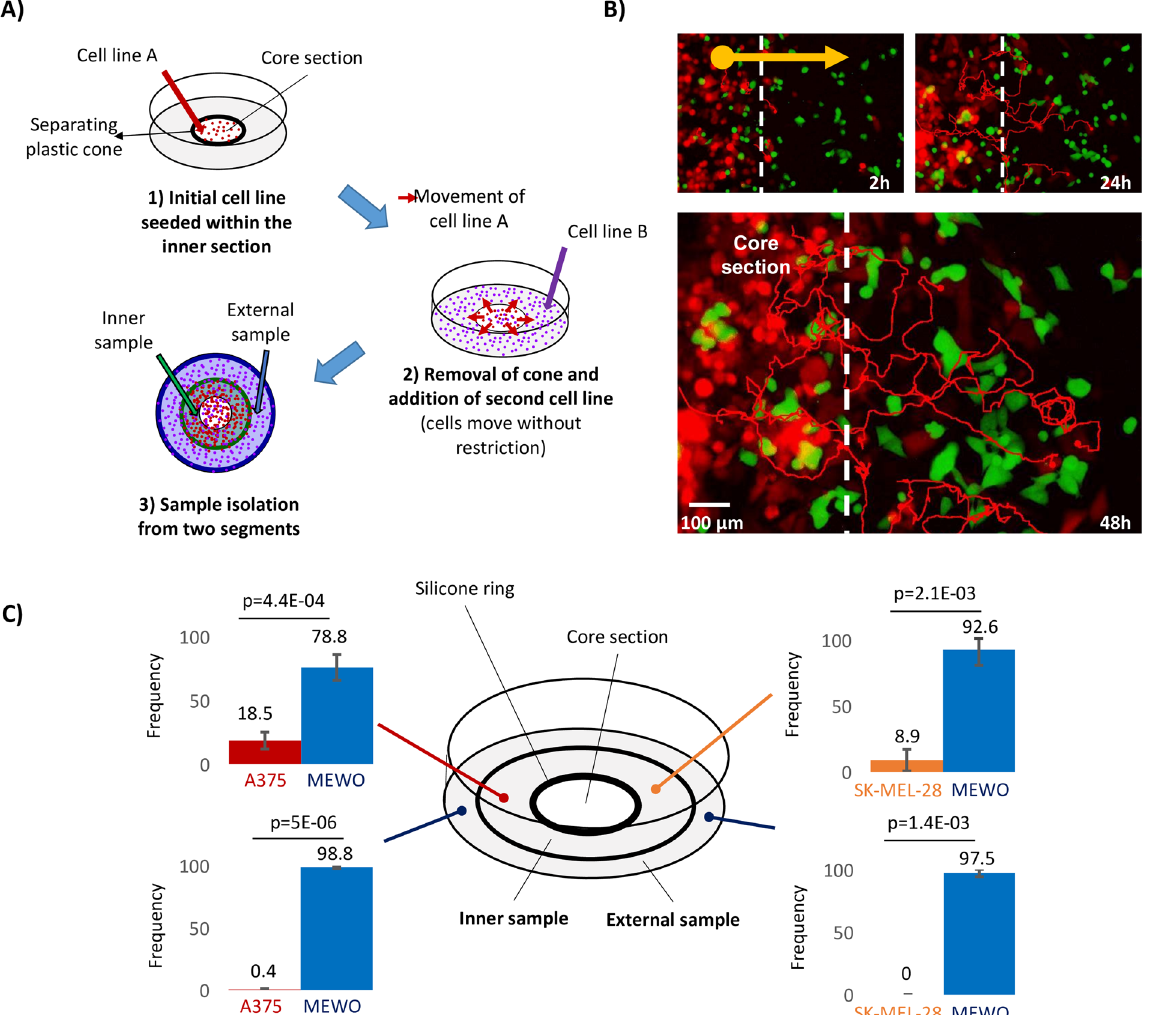
Figure 3. Ring cell invasion assay and migration trajectory. An experimental model of cell line dispersal utilizing three cell lines with dissimilar movement features. During the experiment, spatially separated differentially fluorescent cell lines are mixed in a two-step process ( A ). As a result, mixing of the two cell lines can be documented using fluorescent microscopy as displayed for A375 and Mel-Juso ( B ). Cellular composition measured using next-generation sequencing ( C ). In each case, the cell lines with higher velocities (A375: red and SK-MEL-28: orange) were paired with the MEWO (blue) cell